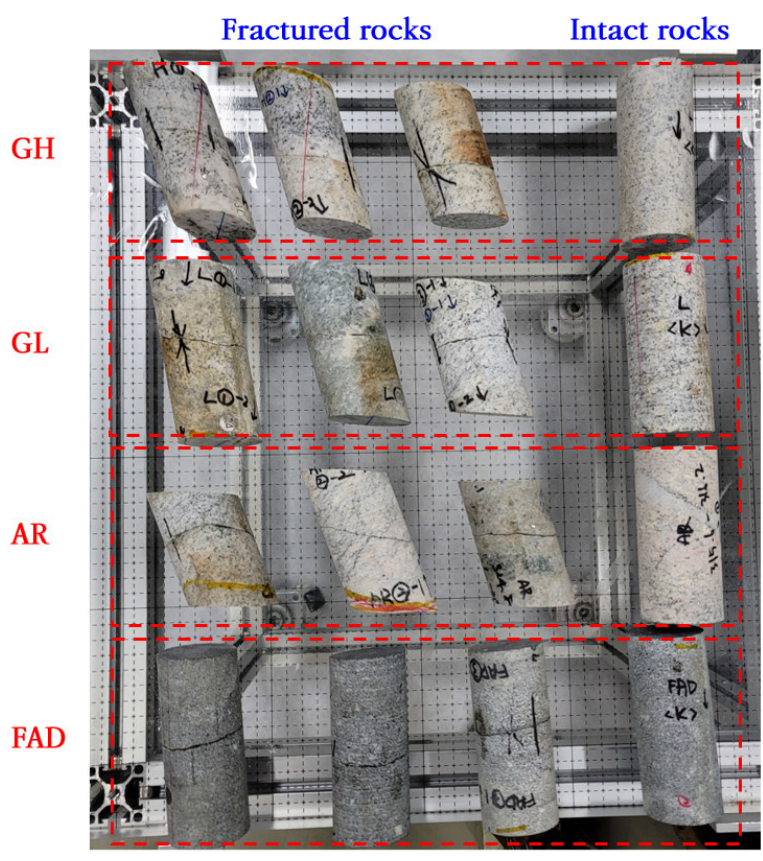
Figure 8. Intact and fractured rock specimens sampled to investigate the applicability of the pro- posed technique. Table 1. Physical and mechanical properties of the specimens used in this study.